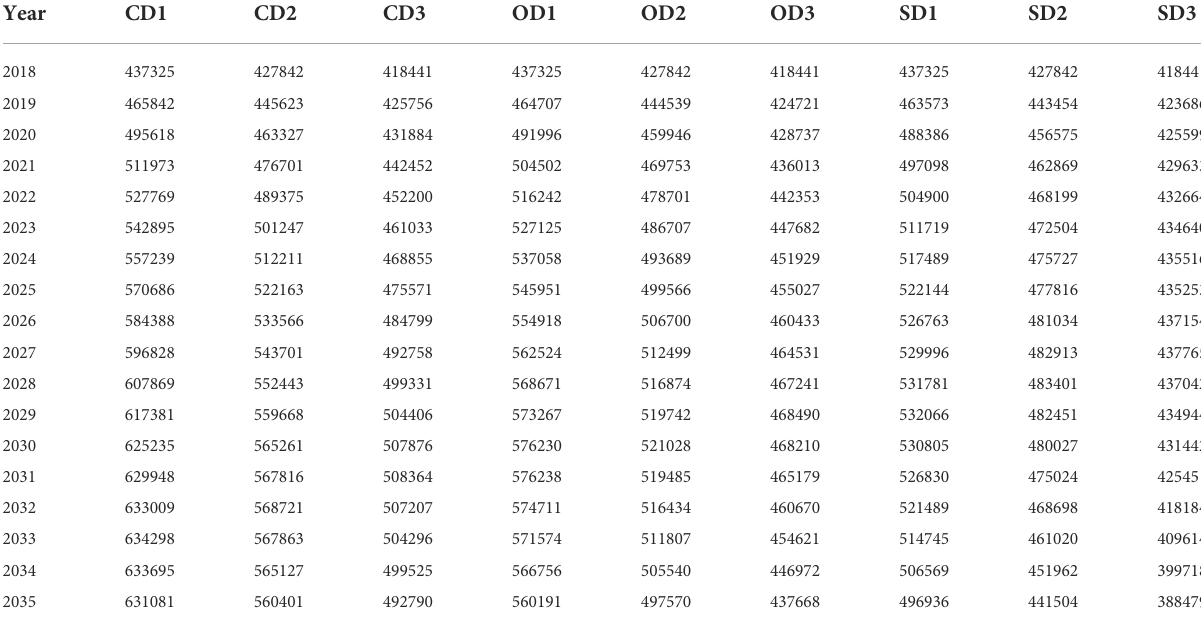
TABLE 12 Simulation results of China ’ s coal consumption scenario (unit: 10 4 tons).